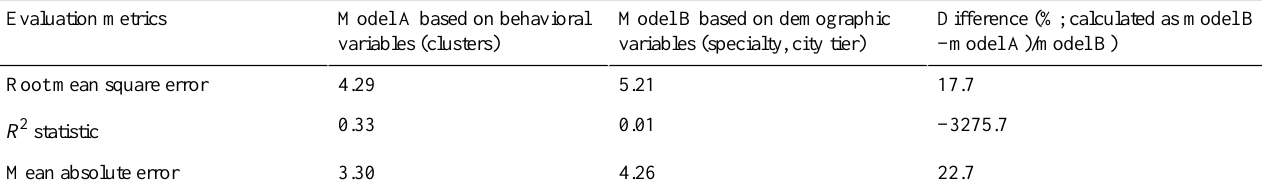
Table 6. Comparison between regression models for engagement time based on 10-fold cross-validation error